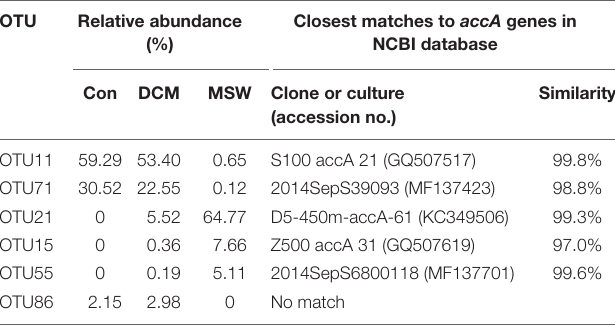
TABLE 3 | Relative abundance (%) of 12 accA OTUs represented by the top three abundant reads from at least a single sample and their closest matches retrieved from NCBI